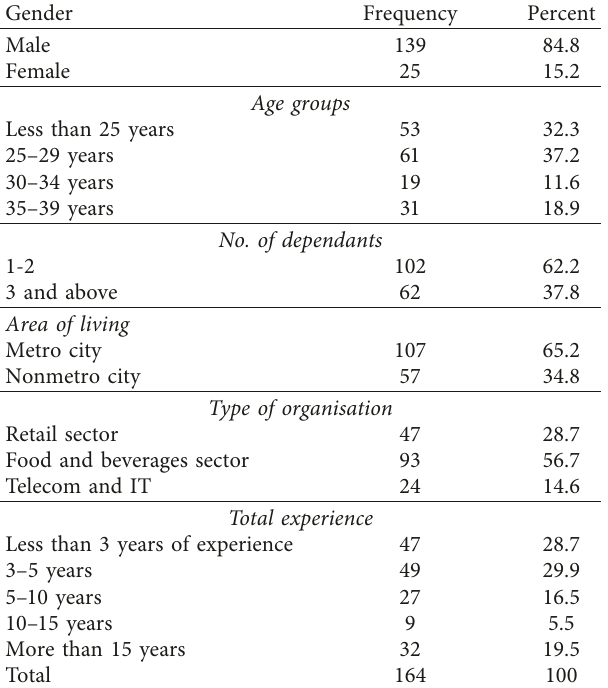
Table 3: Regression model.